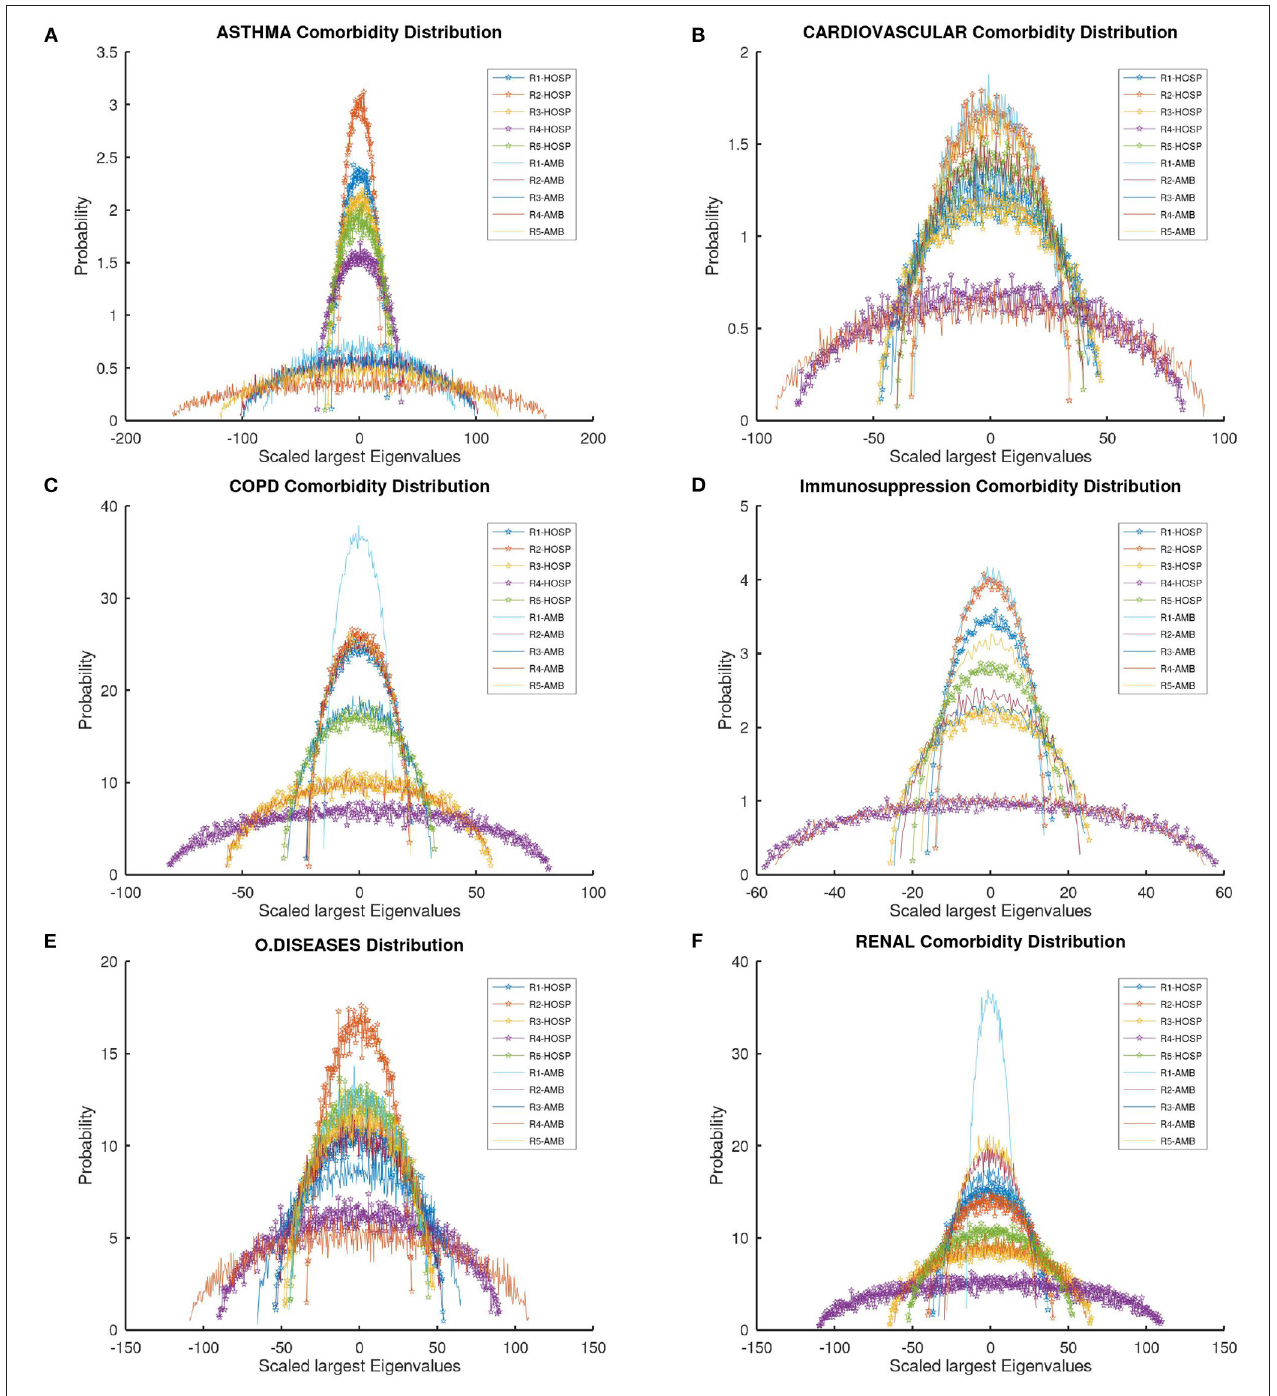
FIGURE 2 | Empirical spectral distribution from the Wigner overlapping semicircular shapes by comorbidities in all regions of Mexico.